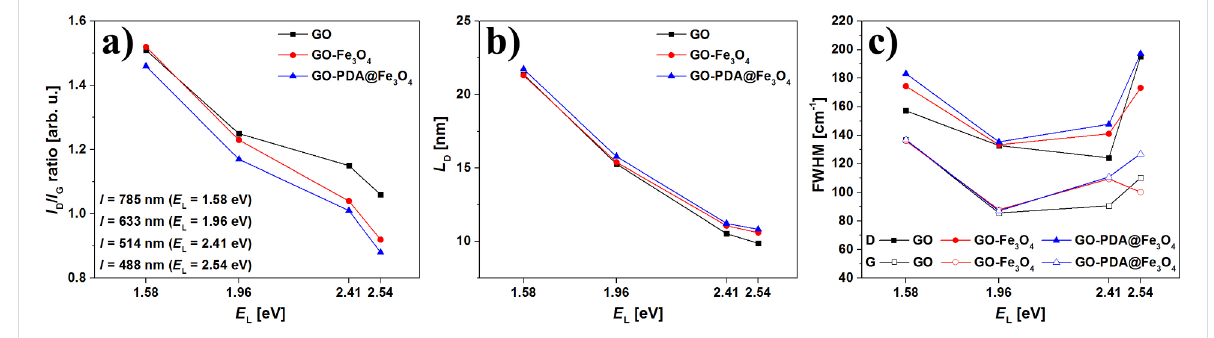
Figure 4: I D / I G ratios (a), mean defect distance ( L D ) (b) and FWHM (c) calculated from Raman spectra of rGO, rGO-Fe 3 O 4 and rGO-PDA@Fe 3 O 4 aerogel samples.